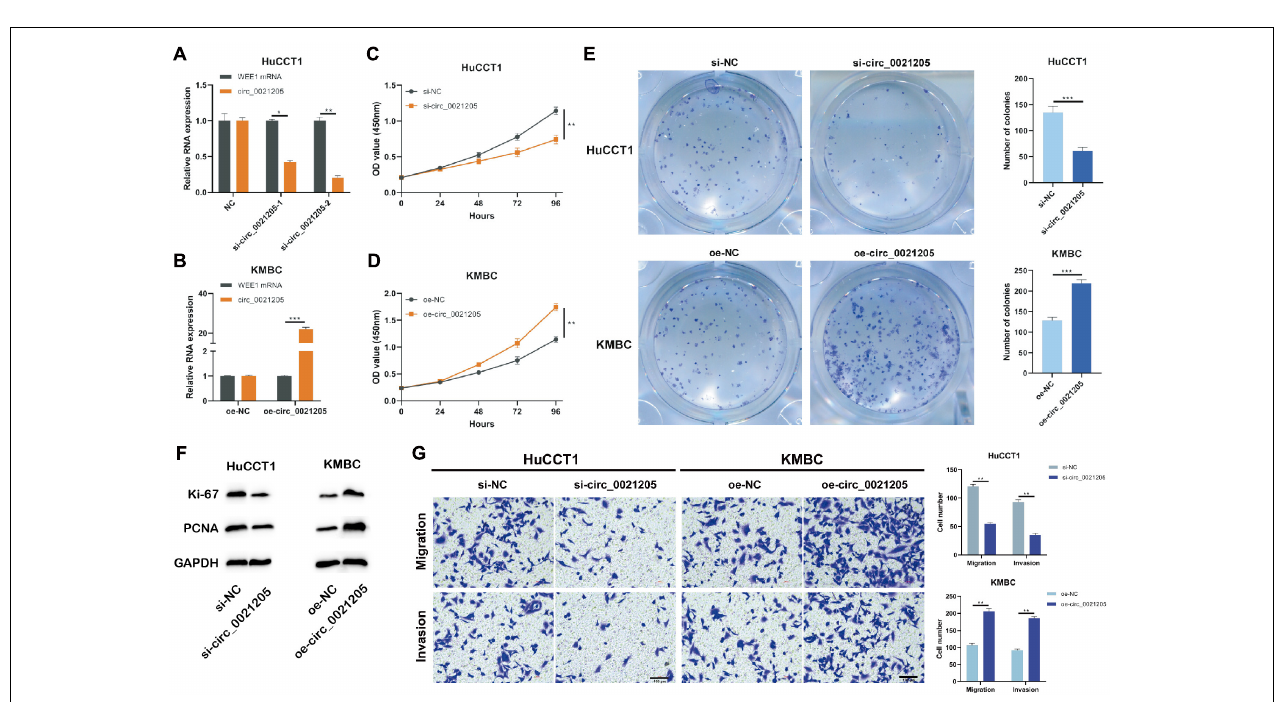
FIGURE 2 | Circ_0021205 promotes the proliferation, migration and invasion of CCA cell. (A,B) HuCCT1 cells were transfected with si-NC, si-circ_0021205-1, or si-circ_0021205-2. KMBC cells were transfected with oe-NC or oe-circ_0021205. The transfection efficiencies were analyzed by qRT-PCR. (C,D) The proliferation of transfected HuCCT1 and KMBC cells were determined by CCK-8 assay. (E) Colony formation assay were performed to detect the proliferation of HuCCT1 and KMBC cells transfected with si-circ_0021205 and oe-circ_0021205, respectively. (F) The levels of proliferation makers, Ki-67 and PCNA, were investigated using western blotting. (G) Cell migration and invasion were detected using transwell assay. All experiments were repeated at least three time. * P < 0.05, ** P < 0.01, *** P < 0.001.